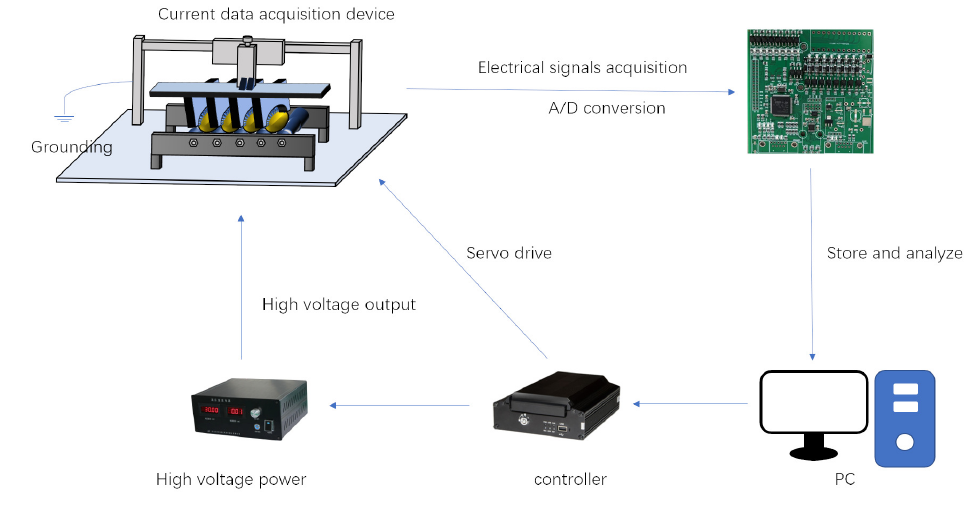
Figure 6. Data acquisition system block diagram.